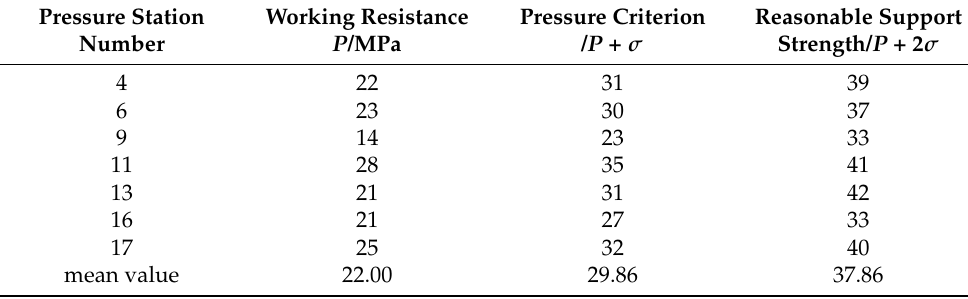
Table 5. Summary of reasonable support strength during periodic